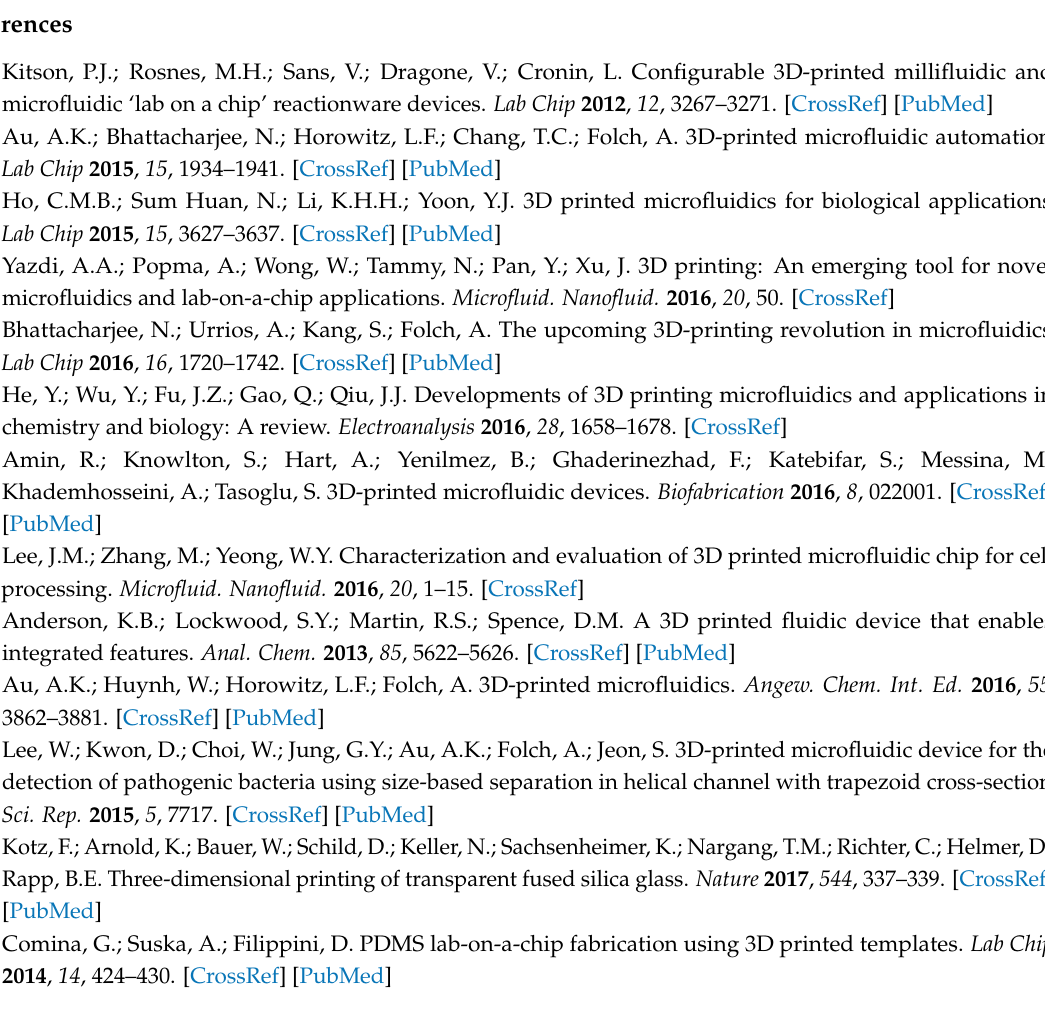
Transmittance of the chip after 20 min removing; Figure S22: Gray scale value of chip images after 40 min removing; Figure S23: Transmittance of the chip after 40 min removing; Figure S24: Gray scale value of chip images after 120 min removing; Figure S25: Transmittance of the chip after 120 min removing; Figure S26: Gray scale value of chip images after 360 min removing; Figure S27: Transmittance of the chip after 360 min removing; Figure S28: Gray scale value of chip images after 720 min removing; Figure S29: Transmittance of the chip after 720 min removing; Figure S30: Chip images after different times of removal; Figure S31: Bright field and fluorescent chip images after 10 and 720 min removing; Figure S32: Gray scale value of a rectangle cross-section chip after 10 min removing; Figure S33: Transmittance of the rectangle cross-section chip after 10 min removing; Figure S34: Gray scale value of a circle cross-section chip after 10 min removing; Figure S35: Transmittance of the circle cross section chip after 10 min removing; Figure S36: Gray scale value of a half-circle cross section chip after 10 min removing; Figure S37: Transmittance of the half-circle cross-section chip after 10 min removing; Figure S38: Gray scale value of a triangle cross-section chip after 10 min removing; Figure S39: Transmittance of the triangle cross-section chip after 10 min removing; Figure S40: Transmittance results of four different cross-sections at 0, 1, 3, 5, and 10 min after removing inner sacrificial materials at 70 ◦ C using vegetable